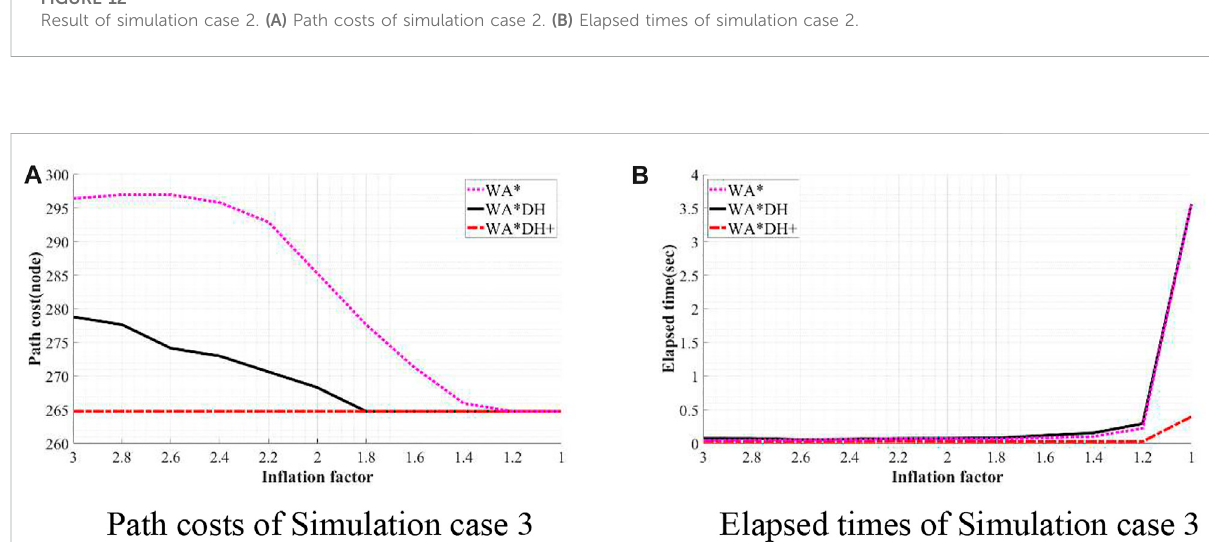
FIGURE 13 Results of simulation case 3. (A) Path costs of simulation case 3. (B) Elapsed times of simulation case 3.